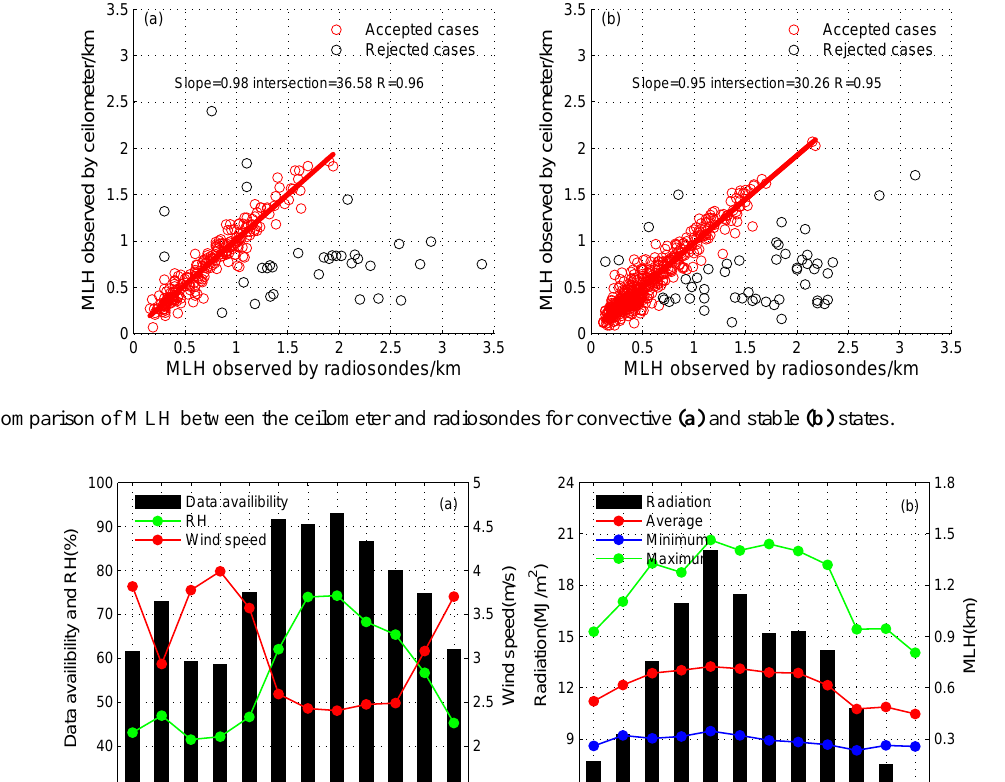
JanFebMar AprMayJun Jul AugSepOct Figure 7. Monthly variations in the effective rate, wind speed, and RH (a) , and MLH and total radiation flux (b) in Beijing.